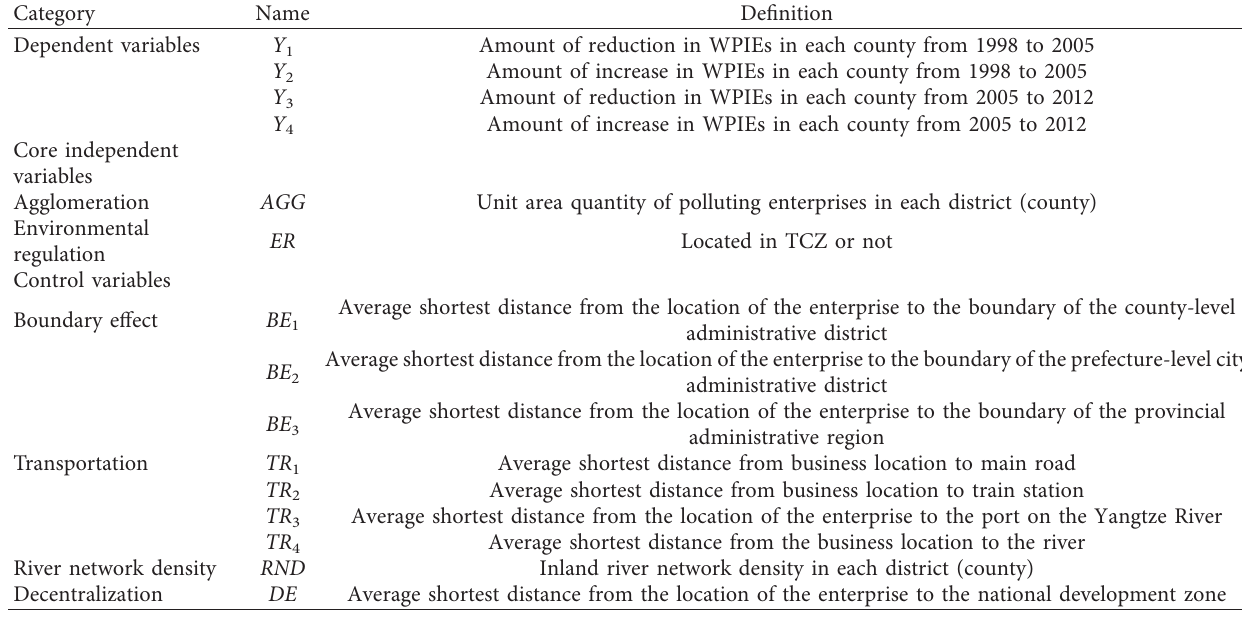
Table 3: Definitions of variables.